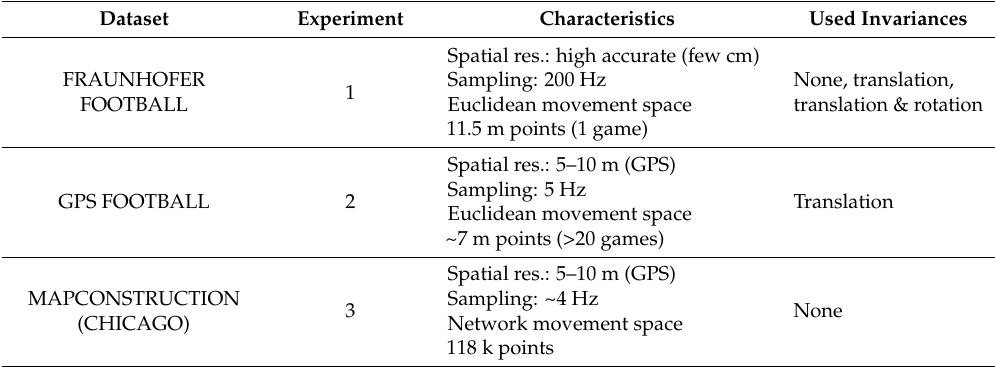
Table 2. An overview of the different datasets used for the experiments in this